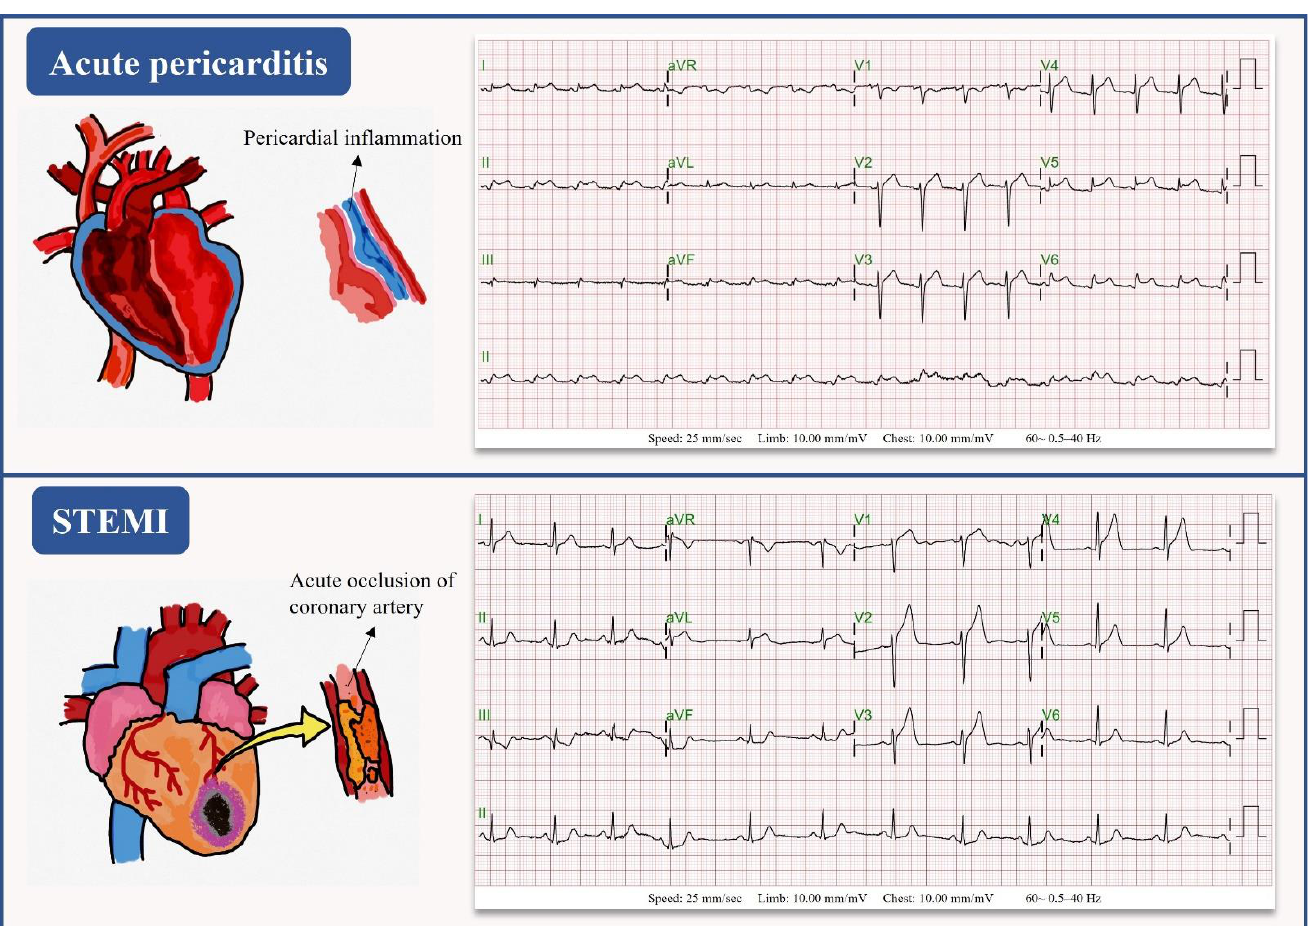
Figure 4. Different impacts of acute pericarditis and STEMI in the physical heart. Inflammation of pericardium resulted in acute pericarditis ( upper panel), whereas STEMI is caused by the acute total occlusion of epicardial coronary arteries ( bottom panel).